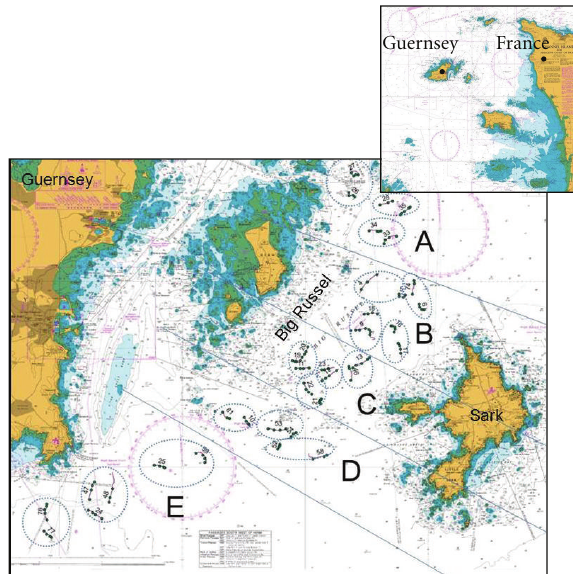
Figure 1: The Bailiwick of Guernsey off the north coast of France. The Big Russel channel is on the eastern side of Guernsey. The channel was divided into Locations (A, B, C, D, and E) and Areas (dotted lines), which comprise 2 or 3 sites (black filled in circles).